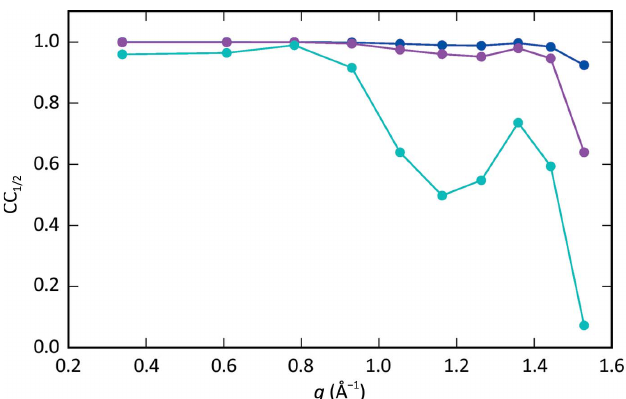
Figure 14 Split correlation coefficient CC 1/2 obtained using the full data set of 586 lattices (blue), 100 lattices (magenta) and ten lattices (cyan). The values are shown as a function of the in-plane momentum transfer q in the centre of the resolution bin. Each resolution bin includes 22 reflections and each point is the average over ten different random splittings of the data